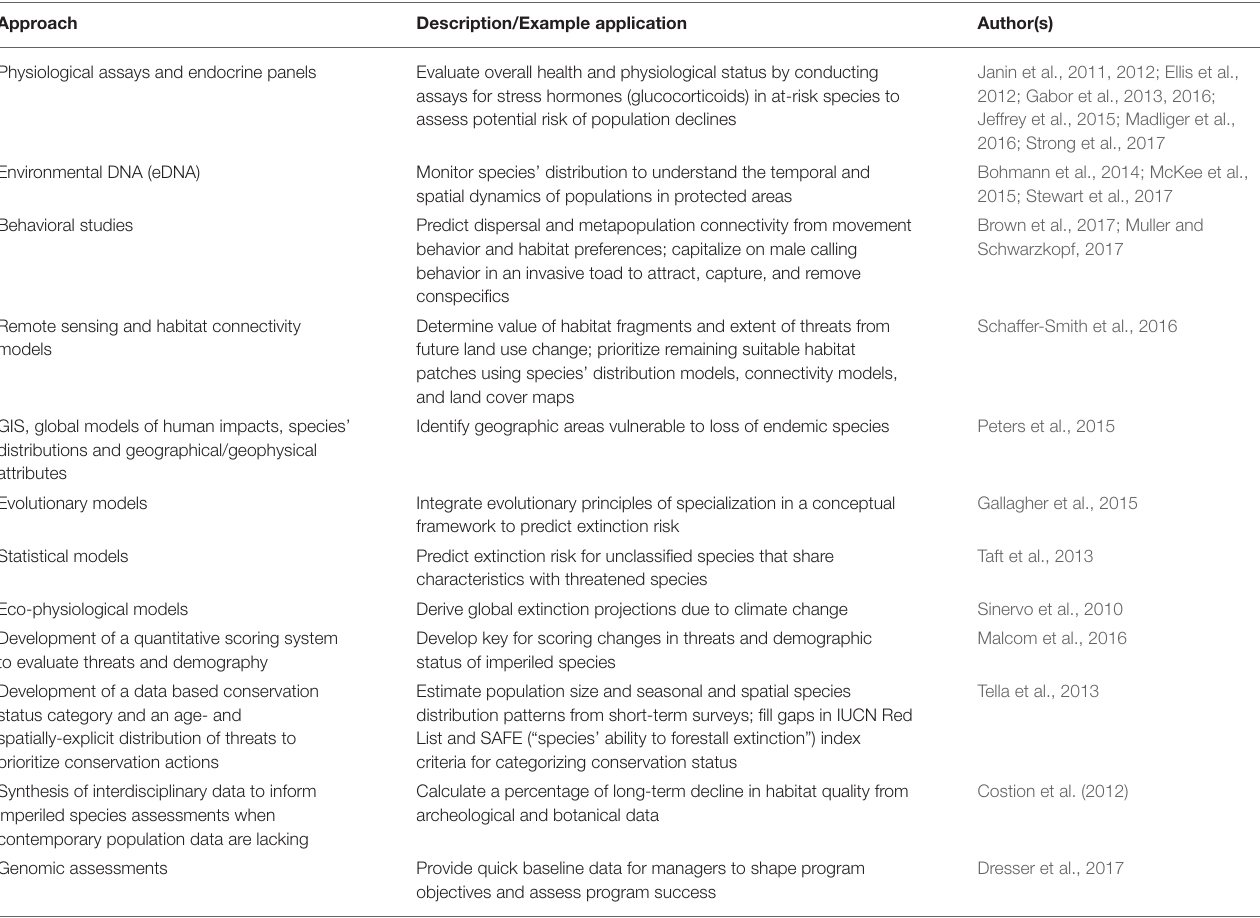
TABLE 1 | Applications of various approaches as conservation tools to help natural resource managers and conservation biologists identify at-risk populations in a time-efficient